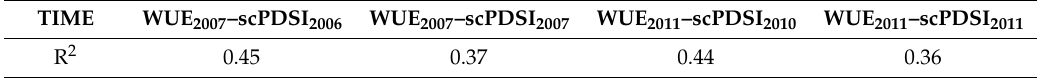
Table 4. Analysis of the lag e ff ect of drought on